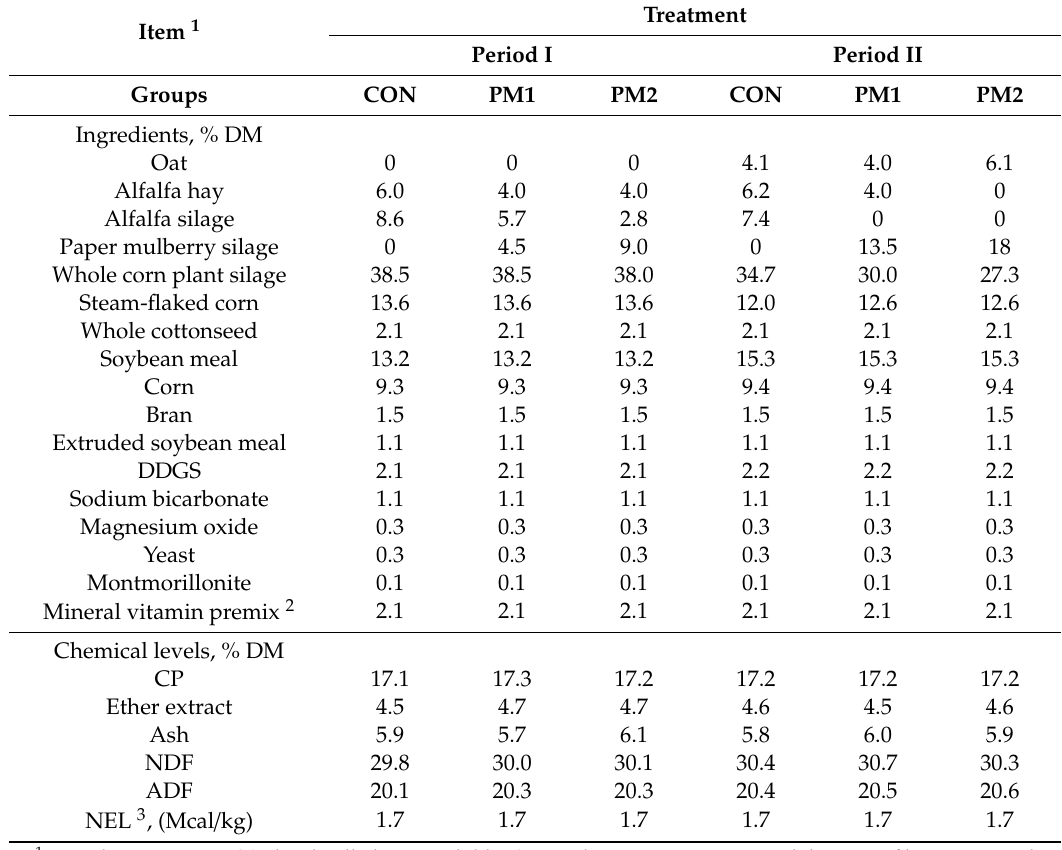
Table 1. The ingredient and nutrient levels of experimental